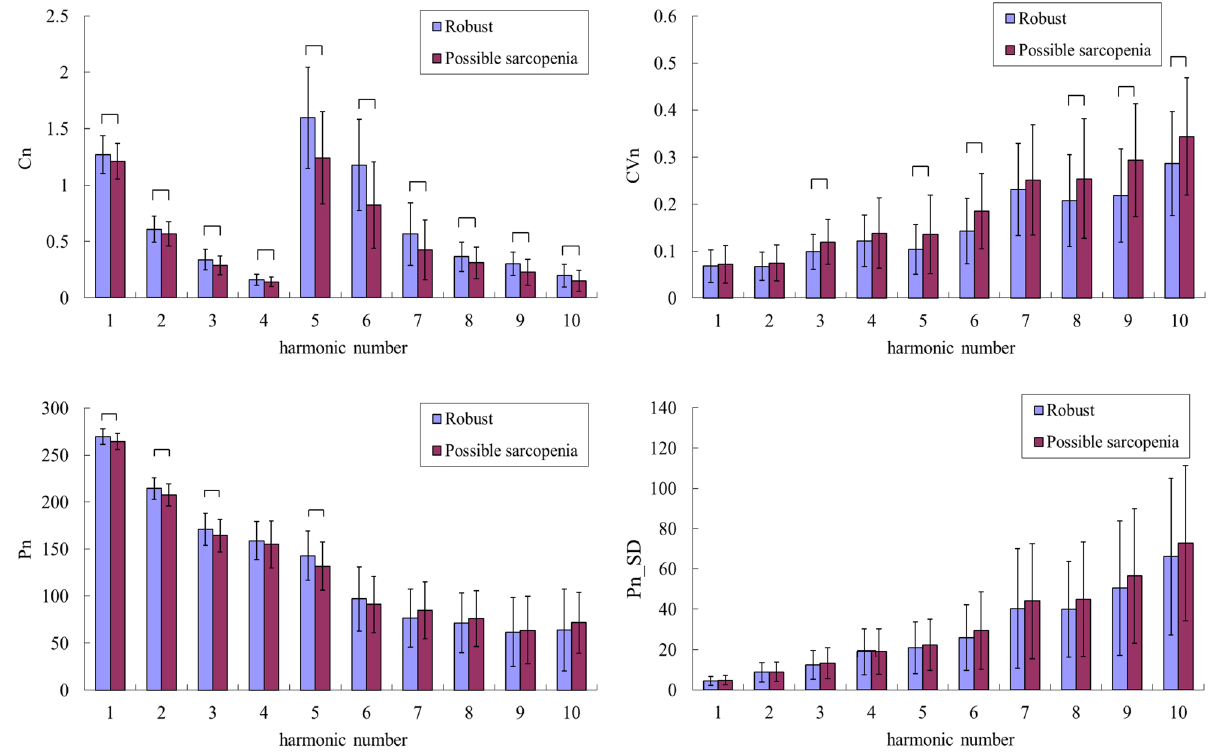
Figure 3. Comparisons of BPW harmonic indices between robust and possible sarcopenia (dynapenia + presarcopenia + sarcopenia): C n , CV n , P n , and P n _ SD . Data are mean and SD values. C 5 – C 10 values have been multiplied by 10 to make the differences clearer. “ (cid:6437) ” indicates p < 0.05. C n values were all significantly smaller in possible-sarcopenia subjects than in robust subjects. CV 3 – CV 10 were larger in